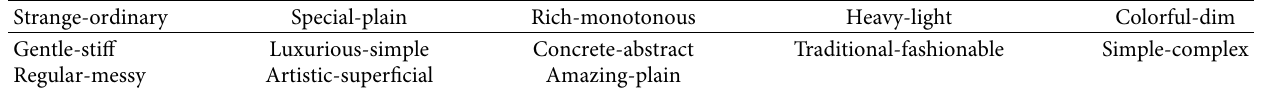
Figure 2: Experimental samples of incense burners in the Ming Dynasty (M) and Qing Dynasty (Q). Table 1: Incense burner Kansei description semantic